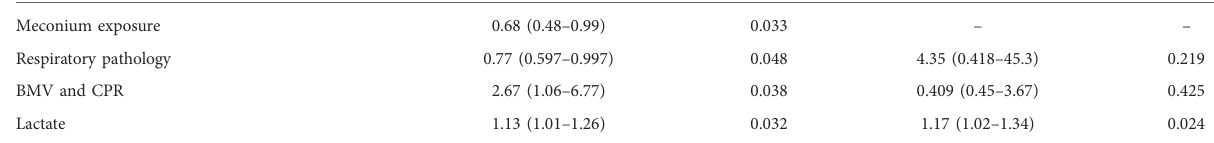
TABLE 8 Factors associated with neonatal hypothermia. Factors associated with